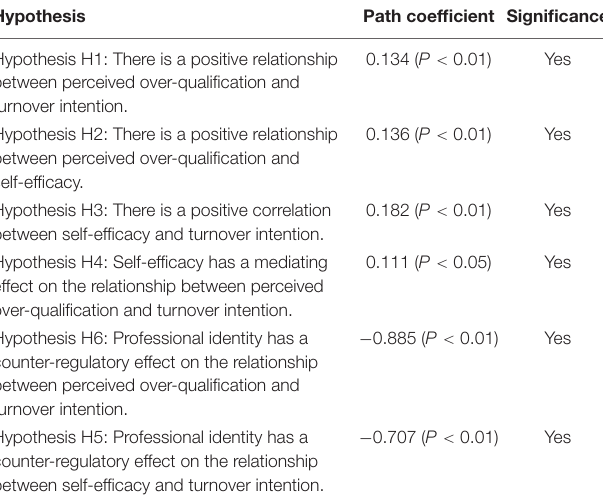
TABLE 9 | Result for self-test analysis. Hypothesis Path coefficient